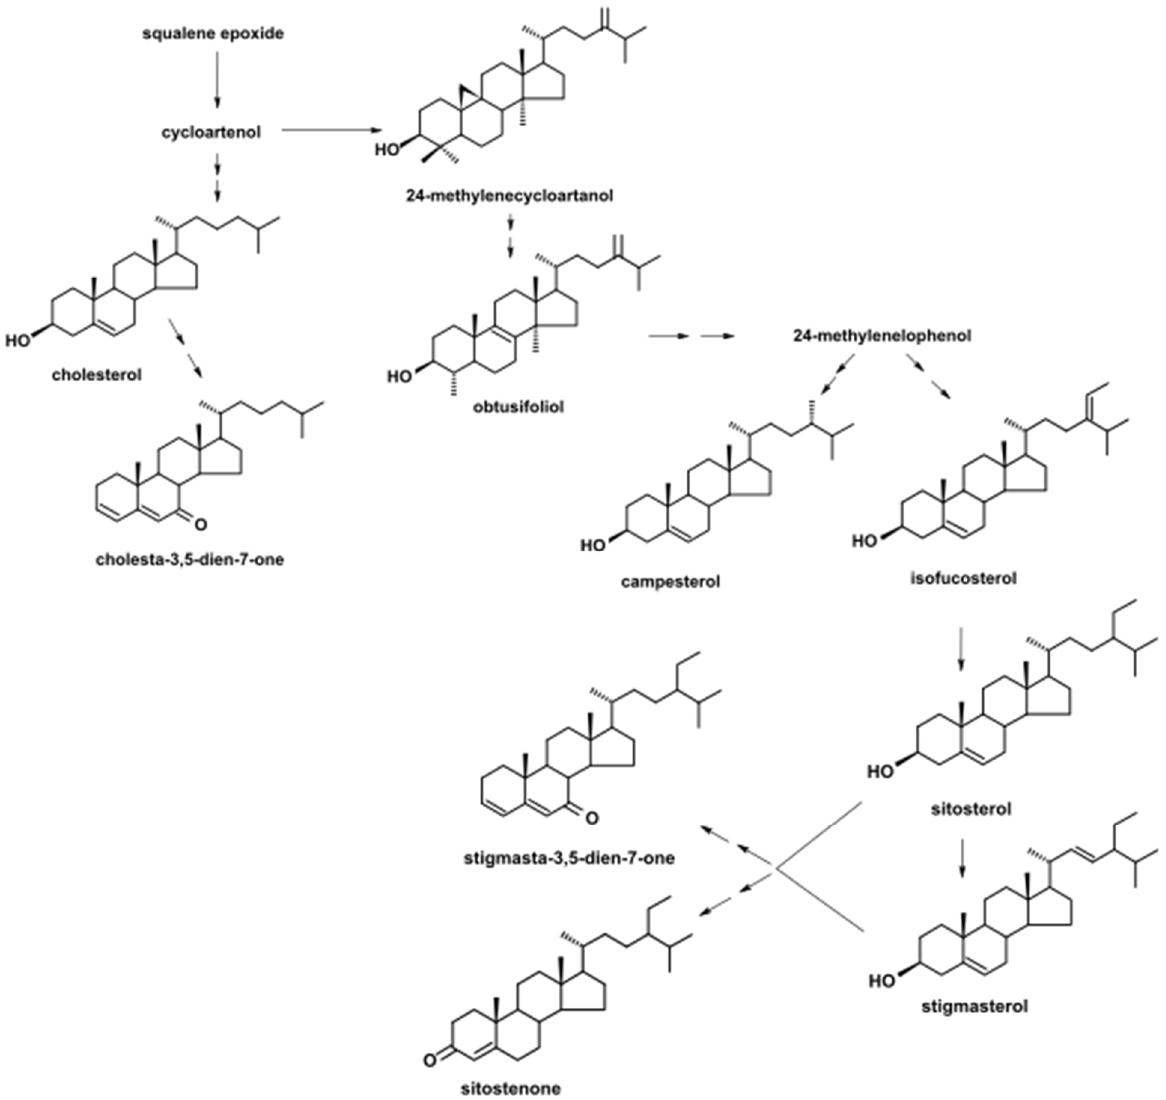
Figure 3. The simplified putative biosynthetic pathway of sterols and steroids in rugosa rose ( Rosa rugosa Thunb.) accessory fruits. The chemical structures of detected compounds are presented, whereas other important intermediates required in the pathway as branching points are incorporated in the scheme only as names. Both steroid ketones, stigmasta-3.5-dien-7-one and sitostenone, can be derived from sitosterol and stigmasterol.